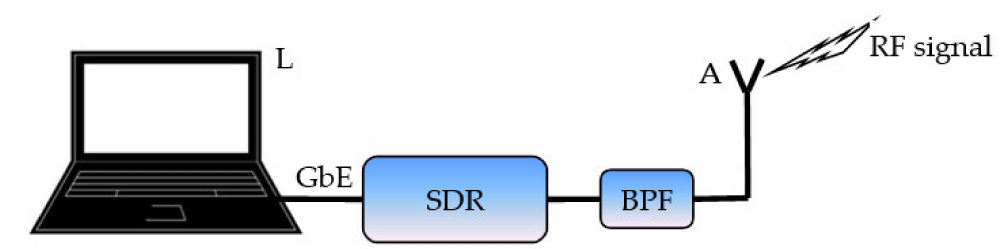
Figure 1. A block diagram of the measurement